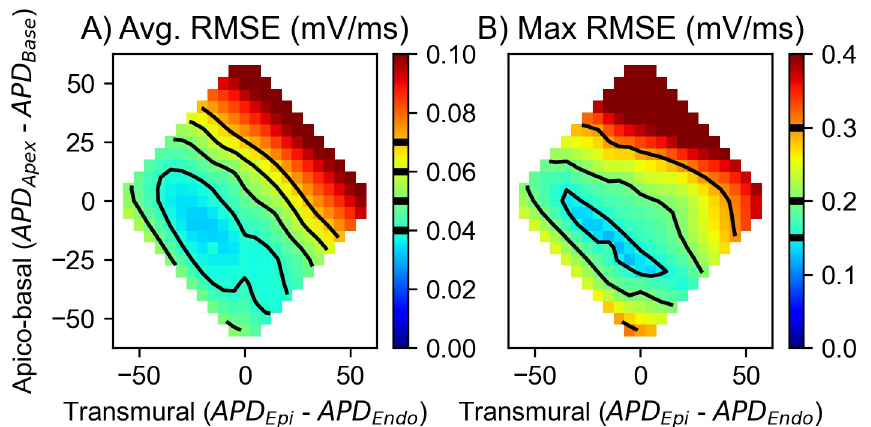
Fig 8. Resulting mean and maximum RMSE of all leads. Resulting mean error of all leads (A) and maximum occurring RMSE error across all leads (B). As the mean error in (A) on its own does not provide a clear global minimum across all combinations of APD gradients, we looked further into maximum occurring error in